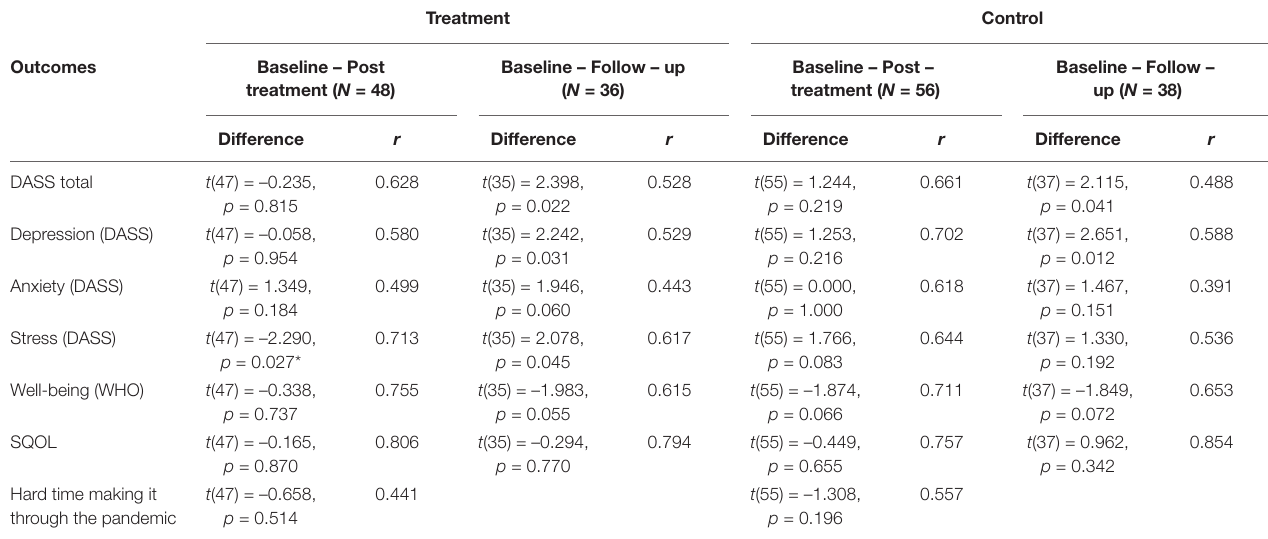
TABLE 3 | The changes and the correlations between baseline and posttreatment and baseline and follow up for both primary and secondary